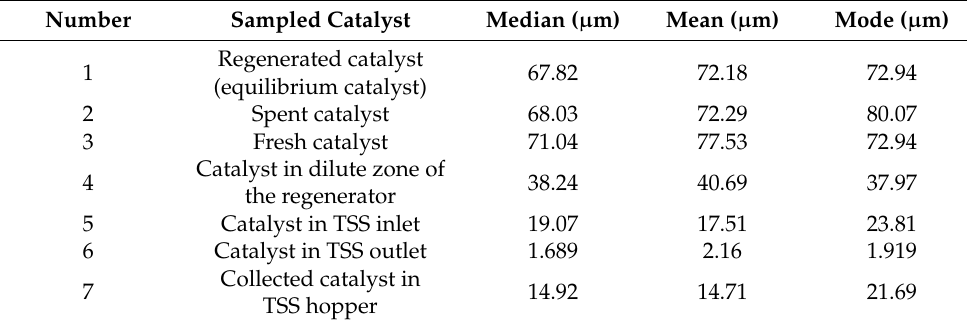
Table 1. Characteristic sizes of catalyst